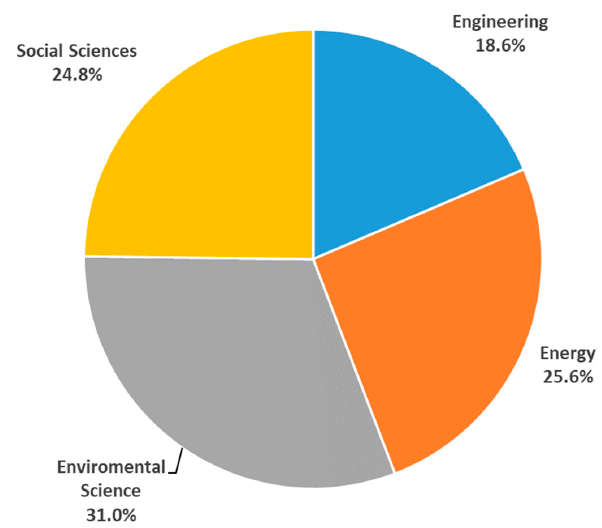
Figure 6. Analyzed documents by country/territory.